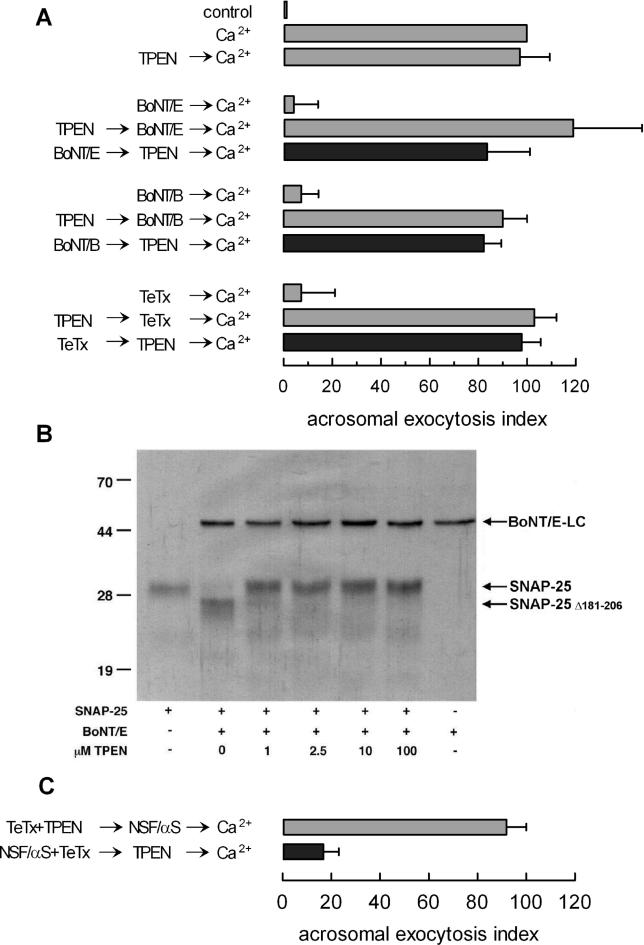
SNAREs Are Assembled in Neurotoxin-Resistant Complexes in Resting Spermatozoa(A) Permeabilized spermatozoa were treated at 37 °C for 15 min with 357 nM BoNT/E, 100 nM BoNT/B, or 100 nM TeTx. Next, 2.5 μM TPEN (see [B]) was added and AE was activated by adding 0.5 mM CaCl2 (10 μM free Ca2+) and the incubation continued for an additional 15 min (black bars). Sperm were then fixed and AE was measured as described in Materials and Methods. Several controls were included (grey bars): background AE in the absence of any stimulation (control); AE stimulated by 10 μM free Ca2+ (Ca2+); TPEN effect on exocytosis (TPEN→Ca2+); inhibitory effect of the neurotoxins on exocytosis (neurotoxin→Ca2+); and block of neurotoxin activity by TPEN (TPEN→neurotoxin→Ca2+).(B) Recombinant SNAP25 (0.7 μg) was incubated for 15 min at 37 °C in the presence of 0.6 μg of BoNT/E and increasing concentrations of TPEN. Samples were then resolved by SDS-PAGE and stained with Coomassie blue. Molecular weight standards are indicated on the left (in kilodaltons). Densitometry and quantitation of the stained bands show 100%, 7%, 92%, 98%, 100%, and 100% of intact SNAP25 in lanes 1–6 (from left to right), respectively.(C) Treatment with TeTx was performed as described in (A), in the presence of 310 nM NSF and 500 nM α-SNAP (NSF/αS) to promote SNARE complex dissociation (black bar). Incubation with NSF/α-SNAP in the presence of TPEN-inactivated toxin did not affect exocytosis (grey bar).The data in (A) and (C) were normalized as described in Materials and Methods (mean ± SEM). Statistical analysis is provided in Table S3.